Question: Sum up the contents of this chart in one sentence.
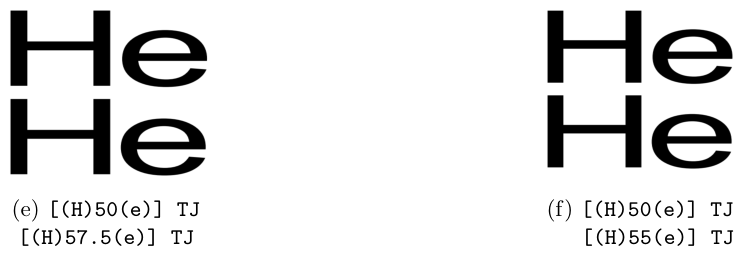
Answer: TJ Operator - control, 50%, 30%, 20%, 15%, 10% (20%)